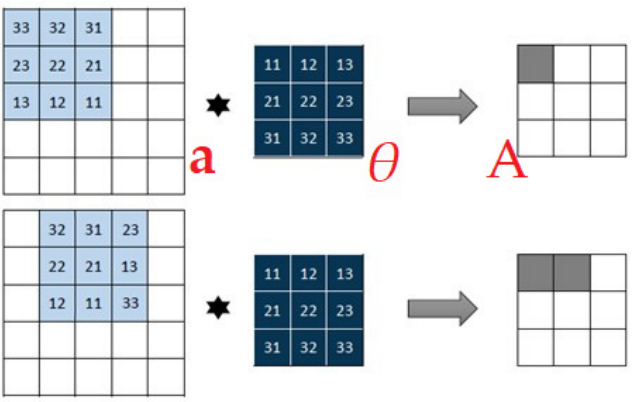
Figure 14. The convolutional process. A matrix of ( m × n ) is convoluted with a matrix of ( u × v ) to obtain a matrix of (( m + u − 1) × ( n + v −